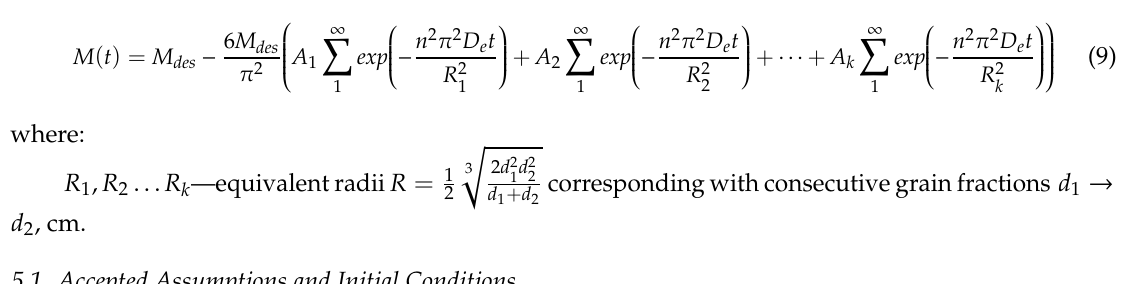
Table 2. Parameters of the coal–gas system for coals from the post-outburst masses and other parameters of the analyzed outbursts.